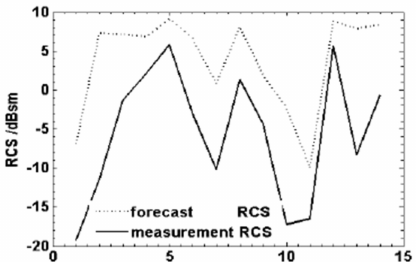
Figure 19. Target count vs. RCS for EISCAT UHF radar 2010 campaign [36]. © 2012 IEEE.